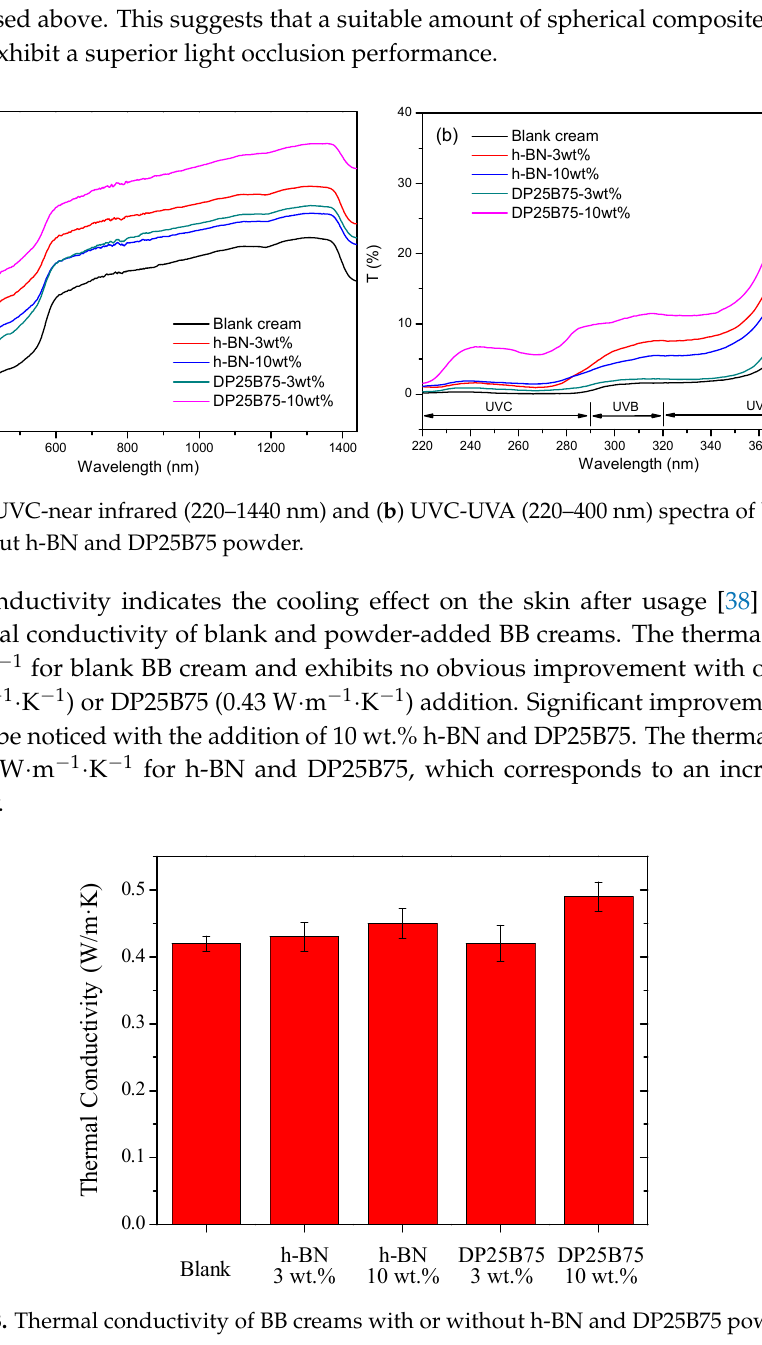
Figure 6. Sun protection factor (SPF) of BB creams with or without h-BN and DP25B75 powder.